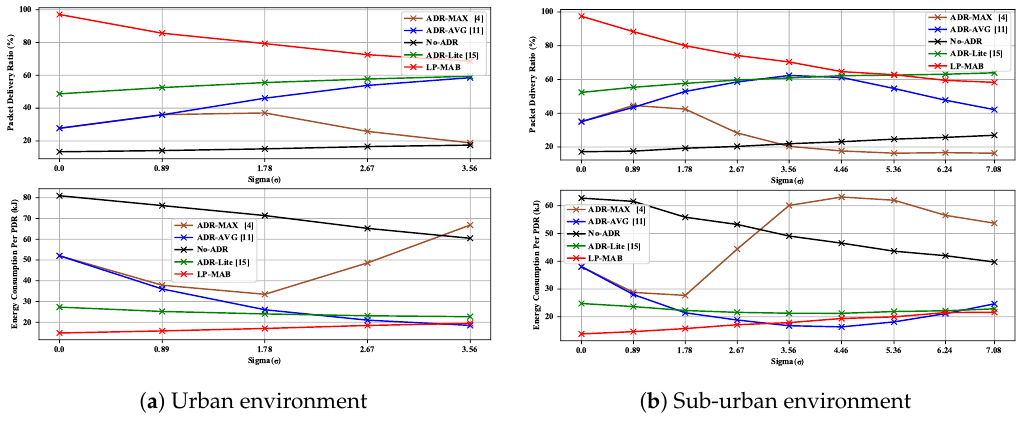
Figure 9. PDR & EC versus different values of channel saturation in Scenario